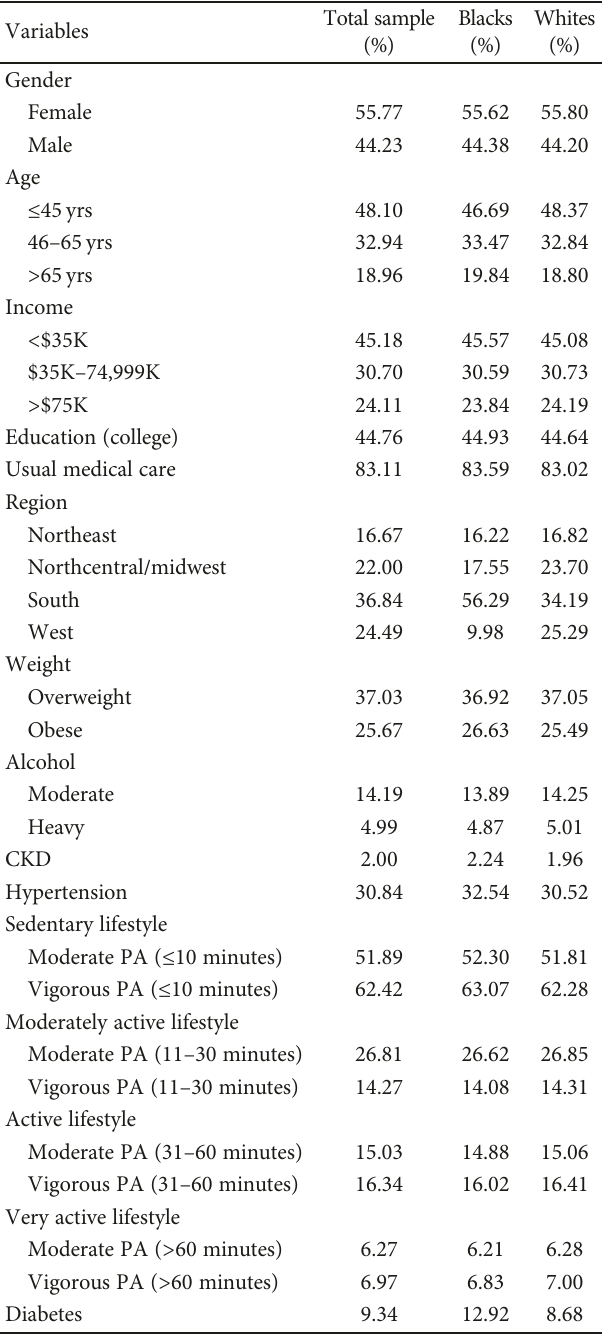
Table 1: Di ff erences in sociodemographic, health behavior, and chronic health conditions among Blacks and Whites ( N